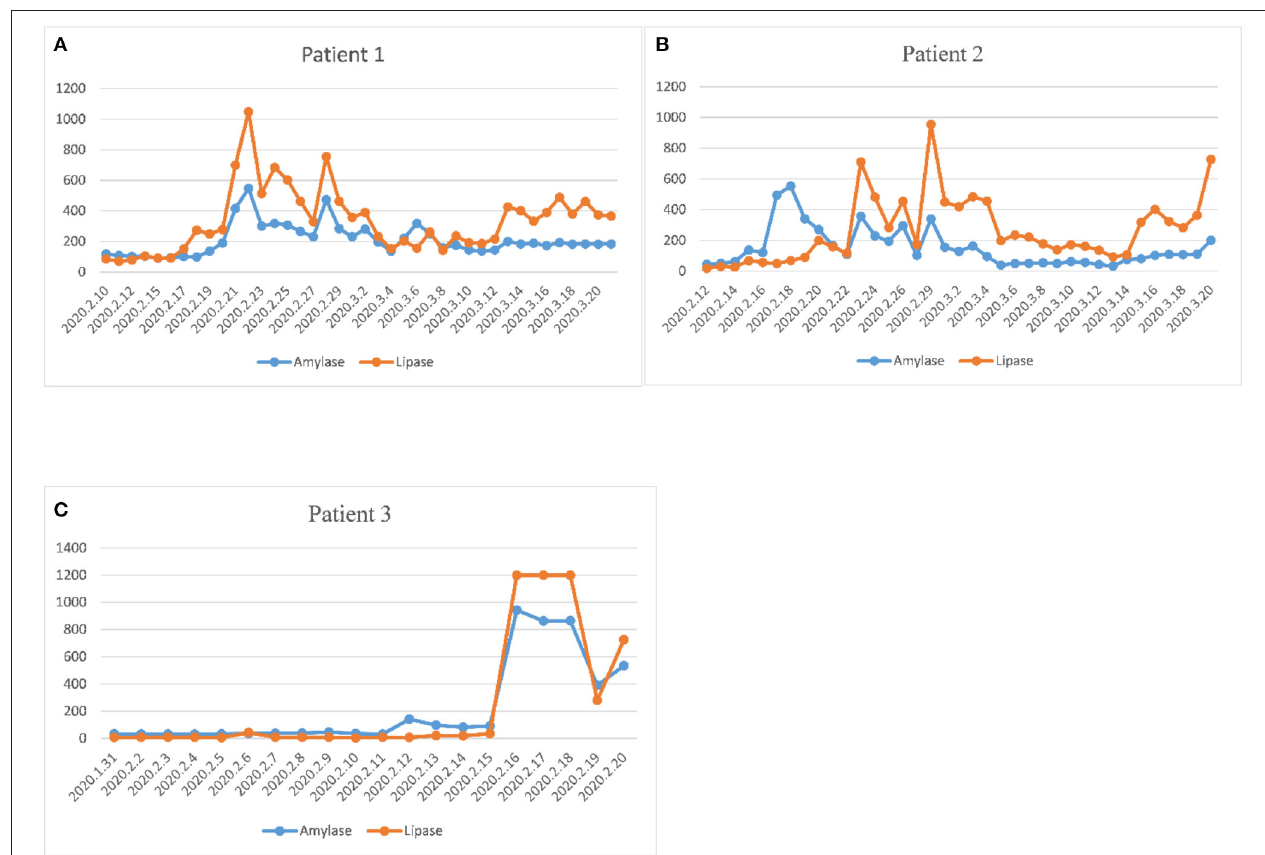
FIGURE 2 | Evolution of plasma amylase and lipase during hospitalization in three pancreatitis patients. (A) The dynamic change of pancreatic enzymes in the first patient. (B) The dynamic change of pancreatic enzymes in the second patient. (C) The dynamic change of pancreatic enzymes in the third patient. The three patients with acute pancreatitis showed similar upward trends of amylase and lipase. The time to the peak of pancreatic enzymes was 11 days in the first patient, 17 days in the second patient, and 17 days in the third